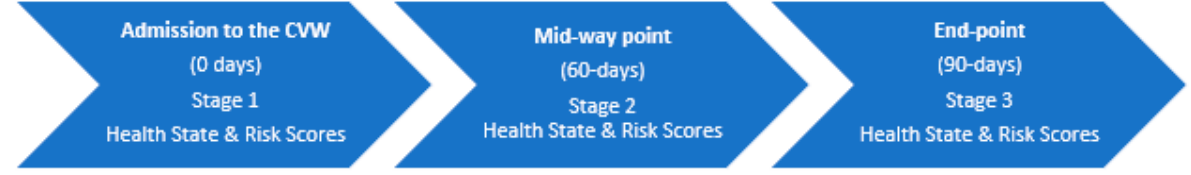
Figure 1. Application of a Markov model for a Community Virtual Ward (CVW) model study design.